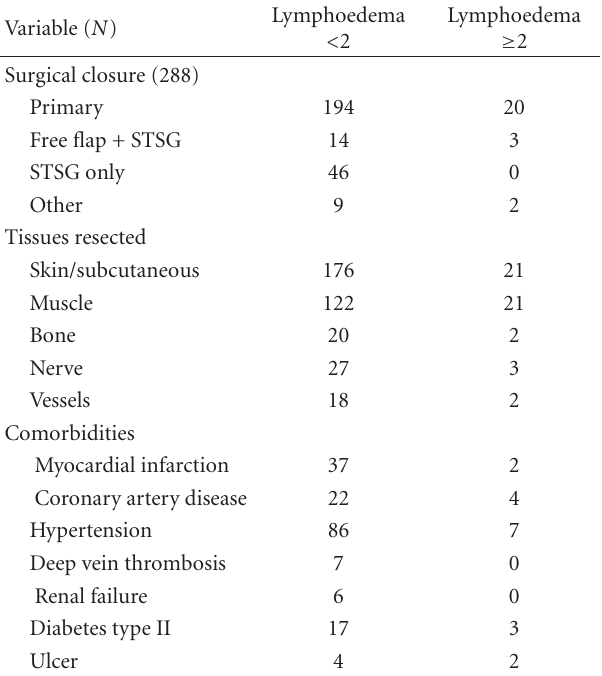
Table 2: Patient demographics and tumor and clinical characteris- tics in relation to lymphoedema severity.